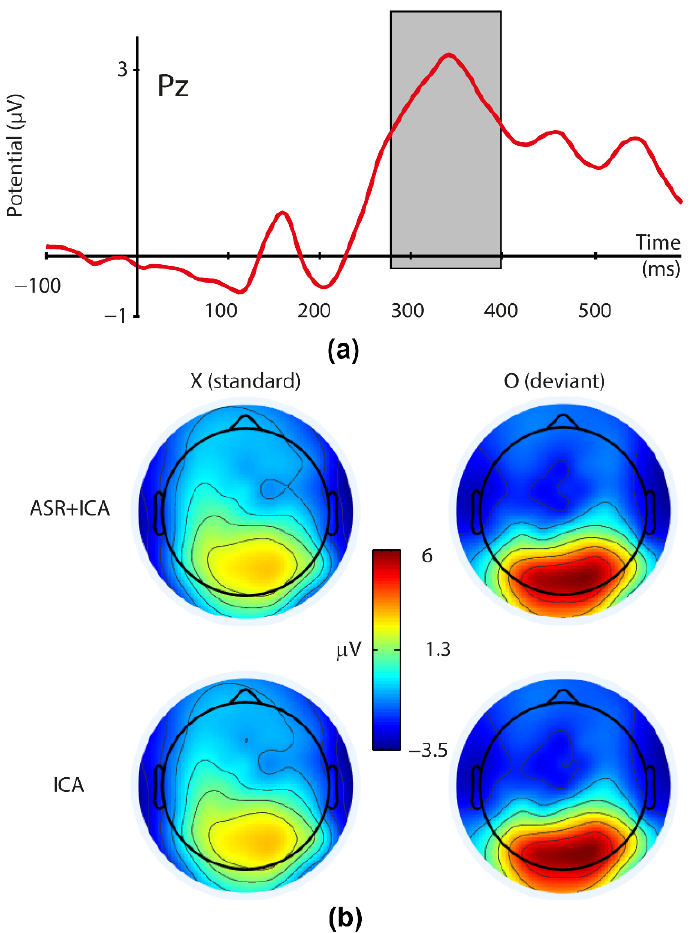
Figure 5. Results of the oddball task conditions: ( a ) ERP on the Pz electrode averaged across conditions; ( b ) scalp map of the amplitude averaged for the 280–400 ms time window.